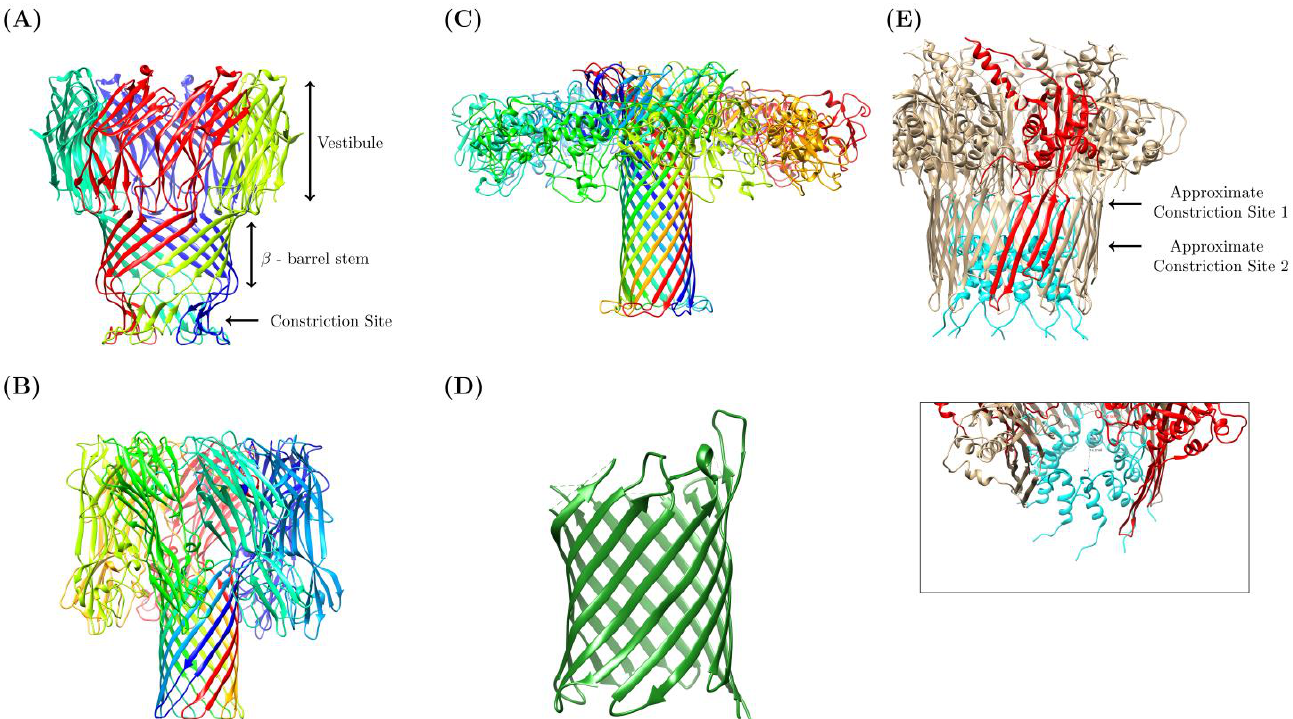
Figure 1. Anatomy of a Nanopore. A depiction of biological nanopores employed in sequencing. ( A ) MspA pore (PDB ID 1UUN) with a constriction site diameter of 1.2 nm, and a stem length of ~3.7 nm ( B ) Alpha Hemolysin (PDB ID 7AHL) with a constriction site diameter of 2.6 nm and a stem length of 5.2 nm ( C ) Aerolysin porin (PDB ID 5JZT) with a constriction site diameter of 1 nm, and a stem length ~10 nm. ( D ) A simplified depiction of OmpG pore (PDB ID 2F1C) with a constriction site of 1.3 nm. ( E ) CsgG-CsgF mutant (PDB ID 6SI7) with two constriction sites: the original CsgG constriction of 1 nm diameter (chain monomer of the original CsgG pore is depicted in red); and a secondary constriction caused by the insertion of CsgF (Cyan residues) with a 1.5 nm diameter. The insert shows the approximated diameter of the second constriction site, ~1.5 nm. Protein chains are depicted in different colors to help with distinction. All proteins were recreated in Chimera utilizing PDB IDs from published protein structures (noted PDB ID numbers).